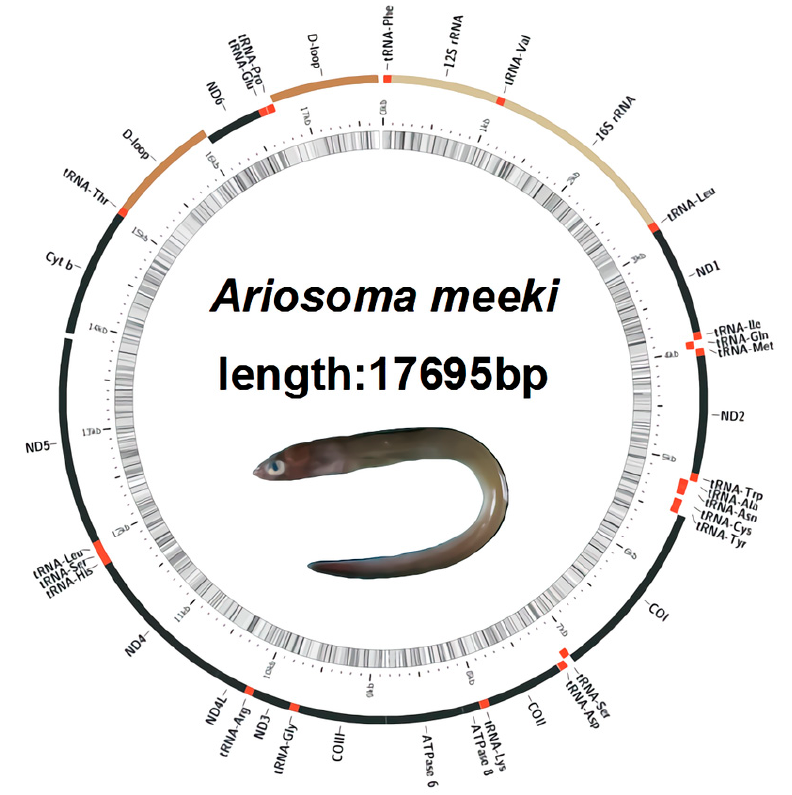
Figure 1. Gene map of the Ariosoma meeki mitogenome. Table 2. Features of the mitochondrial genomes of A. meeki and A. shiroanago.